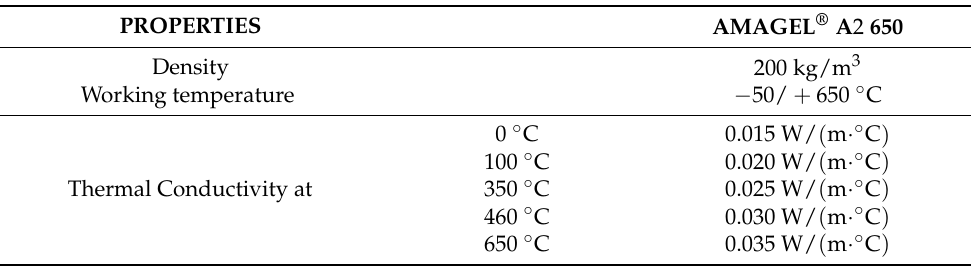
Properties of AMAGEL ( r ) A2 650, see https://amagel.it (Accessed